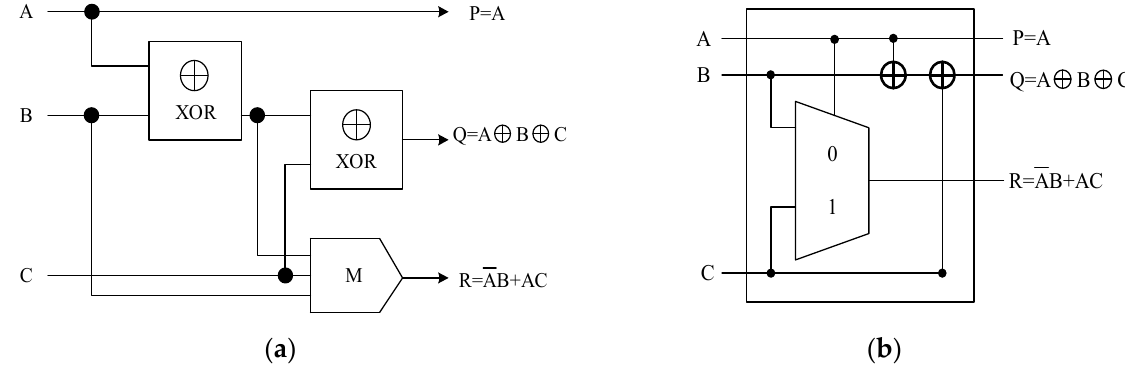
Figure 16. Schematic diagram of a reversible gate in [19]. ( a ) schematic diagram and ( b ) symbol.